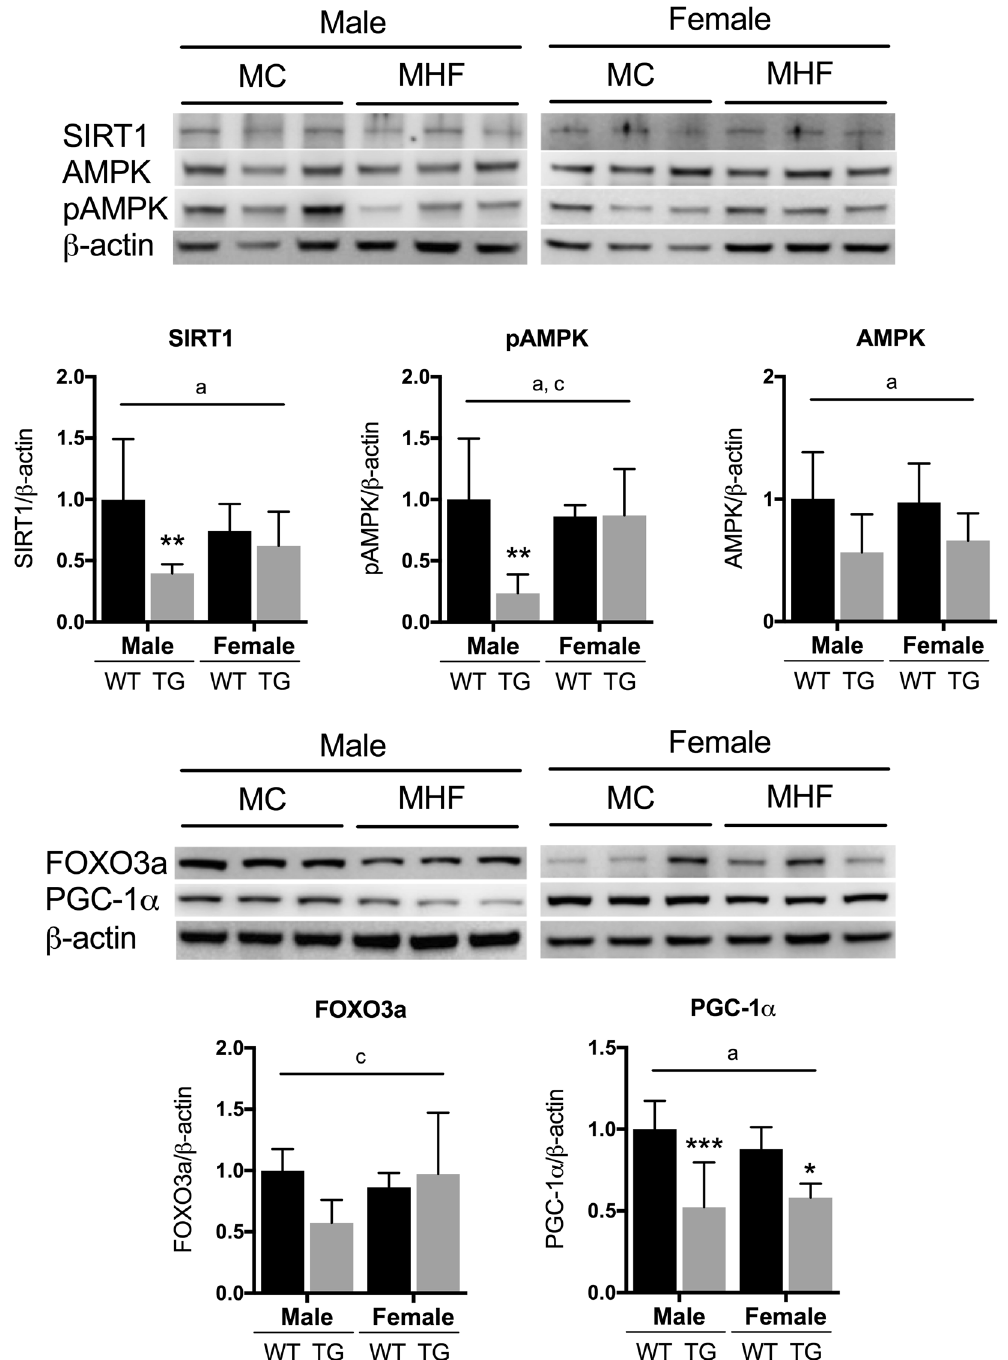
Figure 2. Protein levels of markers of SIRT1 signalling network in male and female offspring kidney. MC (offspring of dams fed chow); MHF (offspring of dams fed high-fat diet). SIRT1 (Sirtuin), PGC-1 α (Peroxisome proliferator-activated receptor gamma coactivator 1-alpha), AMPK α (5 ′ AMP-activated protein kinase alpha), pAMPK α (Phosphorylated AMPK α ) and FOXO3a (Forkhead box O3a). Results are expressed as mean ± SD. Data were analysed by two-way ANOVA followed by Bonferroni post hoc test. ( a ) (P < 0.05, Maternal diet effect), ( b ) (P < 0.5, Sex effect), ( c ) (P < 0.05, interaction effect), * P < 0.05, ** P < 0.01 (vs MC offspring). n =